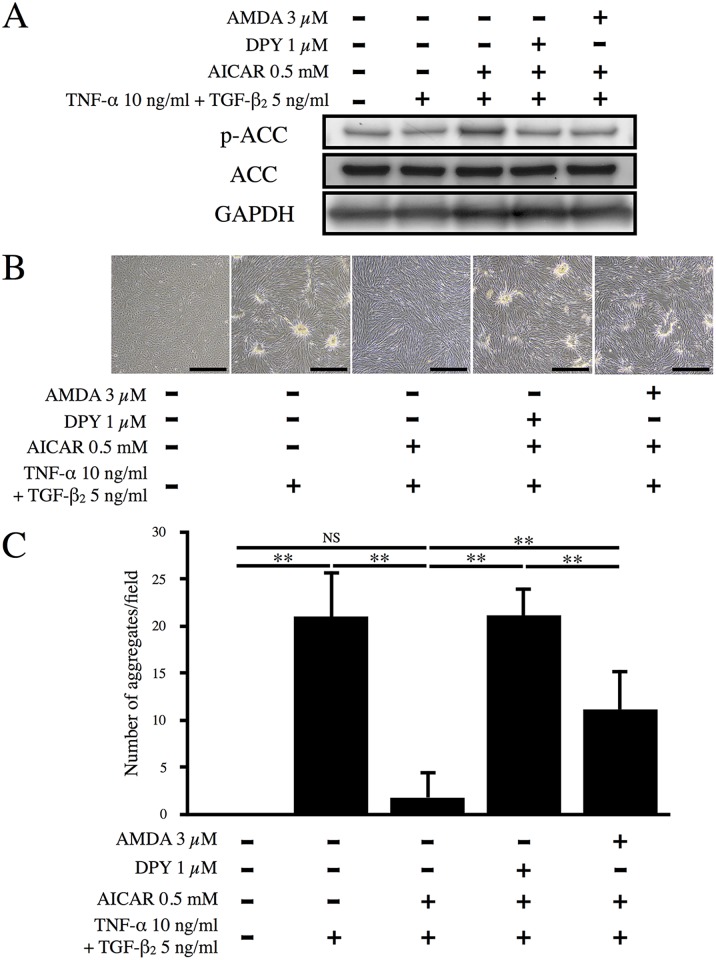
Effect of AICAR on TNF-α/TGF-β2-induced aggregate formation.(A) Phosphorylation of ACC in whole cell lysates was examined by western blot analysis. GAPDH was used as a loading control. (B) ARPE-19 cells were cultured with or without TNF-α and TGF-β2, AICAR, DPY, or AMDA for 48 h. Representative photos are shown. Scale bars = 500 μm. (C) The number of aggregates per microscopic field was counted and analyzed (n = 6). **, p < 0.01; NS, not significant. Error bars, S.E.